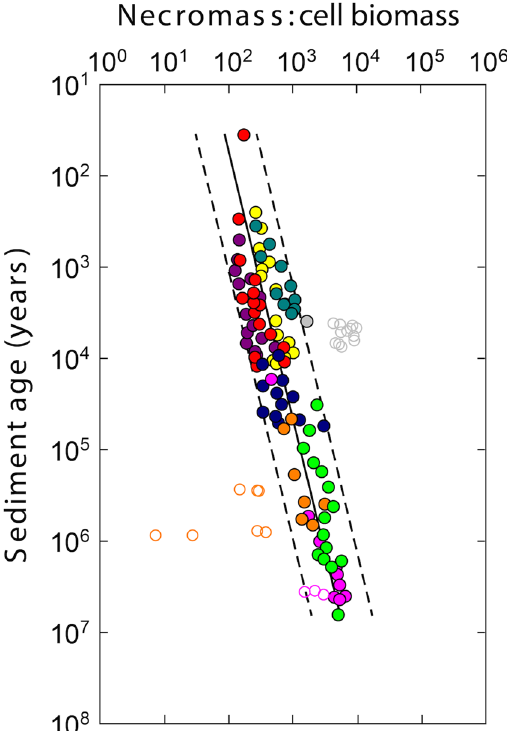
Figure 3. Ratio between THAA-N in microbial necromass and biomass (vegetative cells only). The fraction of THAA-N derived from microbial necromass increases with age relative to that derived from vegetative cells. Note that the concentrations of THAA-N in vegetative cells and necromass were not measured directly, but calculated based on measurements on vegetative cell and endospore abundances and literature conversion factors for the cellular content of THAA-N (see Methods Summary for details on how the calculations were performed). Regression lines show necromass:vegetative cell biomass ratio versus sediment age (solid line; log 10 (necromass:vegetative cell biomass) = 1.405 × log 10 (sediment age) + 0.343, N = 98, R 2 = 0.76, P < 0.0001, least squares analysis) and 95% prediction interval (dashed lines). Open circles denote data points that have been removed from regression analysis (e.g. outliers, sulphate-methane transition zones). Note that sediment age is shown on a logarithmic scale. Colour legend is the same as for Figs 1 and